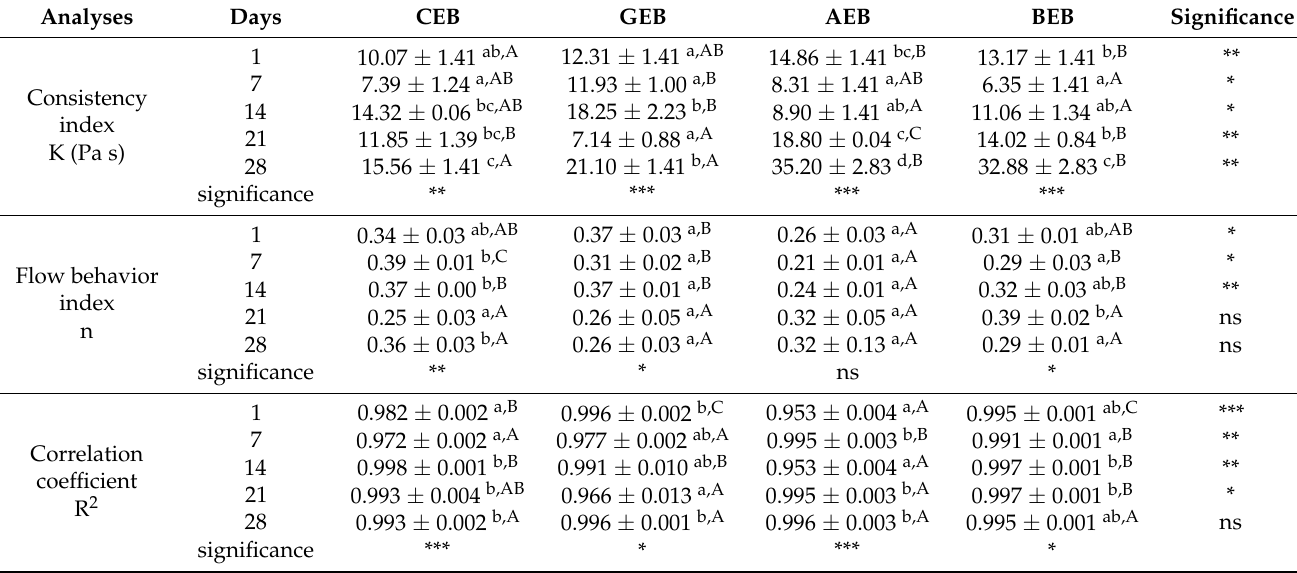
Table 3. Power law model fitting data of flow behavior index (n), the consistency index (K) and regression coefficient (R 2 ) of beverages during storage at 4 ◦ C.